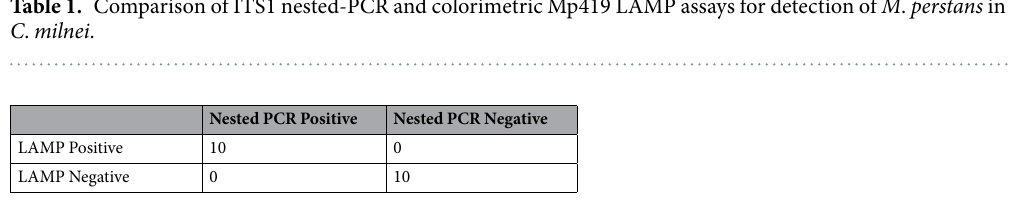
Table 2. Evaluation of Mp419 LAMP for detection of M . perstans in patient samples using the CRS